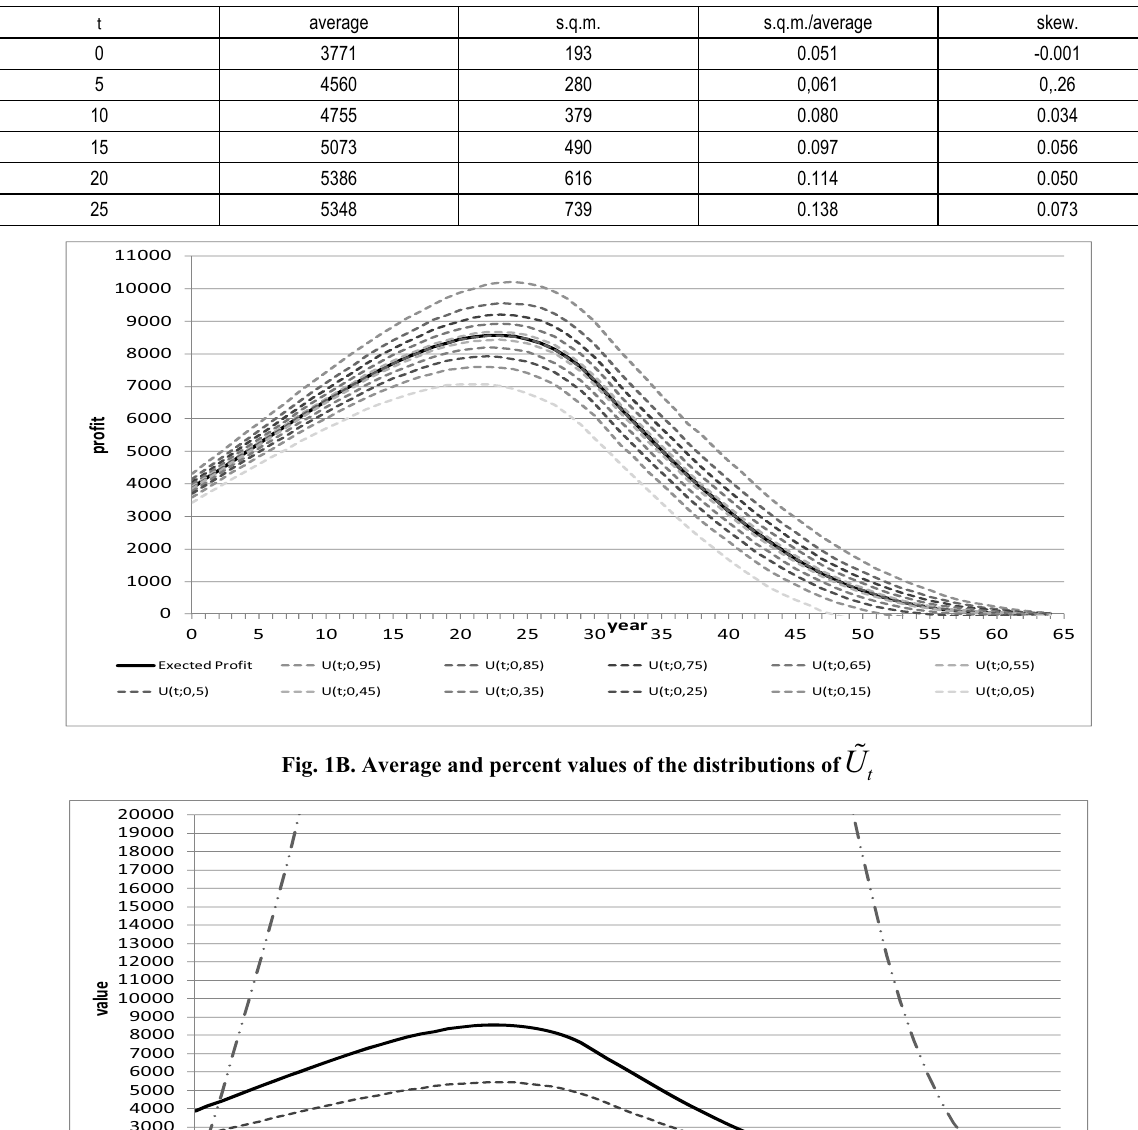
(cid:5) U evidenced for the standard stochasticity level, with contract escapes t